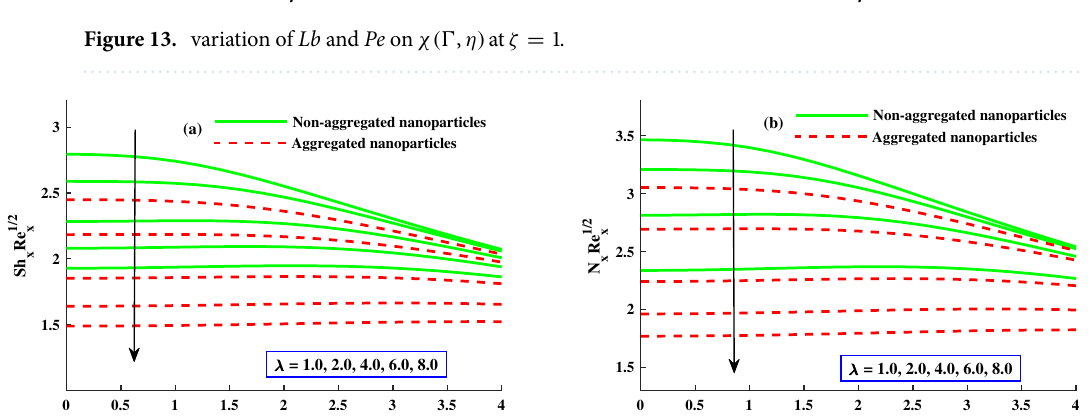
Figure 13. variation of Lb and Pe on χ(Ŵ , η) at ζ